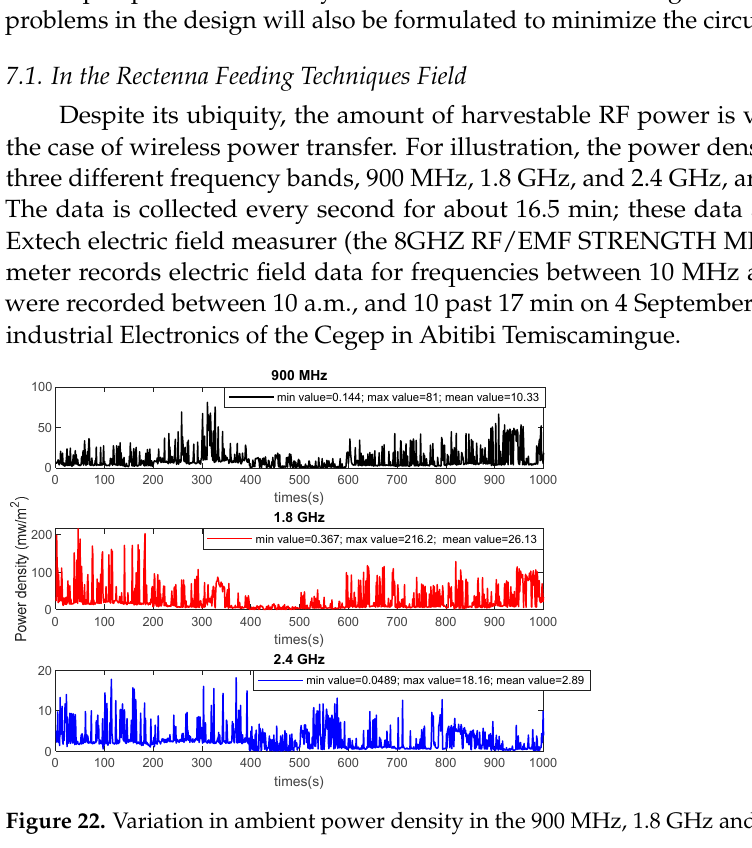
Figure 21. Energy harvesting communication model for solving STTM problem.